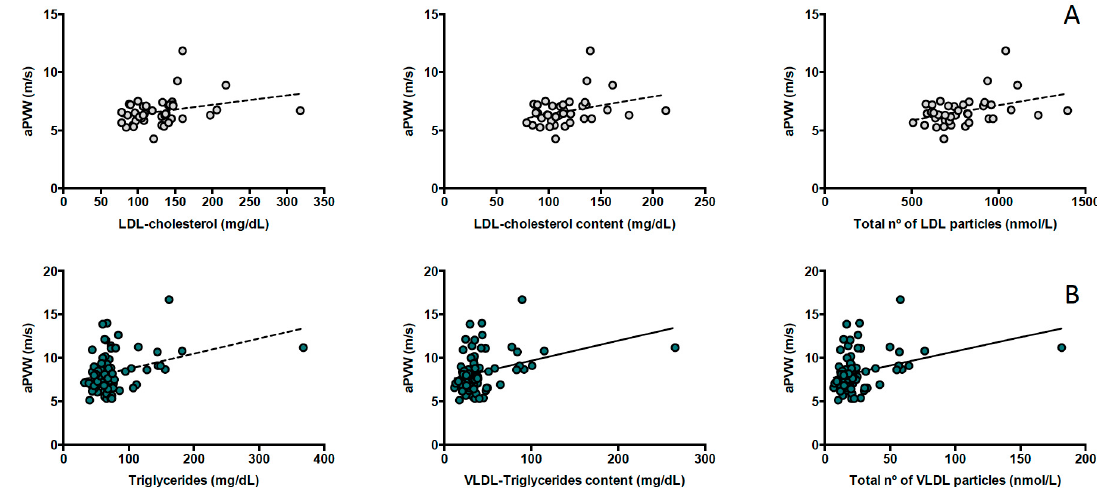
Figure 2. ( A ) Association between aortic pulse wave velocity (aPWV) and NMR-assessed lipoprotein subclass profiles in healthy participants and ( B ) in participants with T1DM. 271 Table 3. Multiple regression analysis for the association between arterial stiffness and NMR-assessed 272 lipoprotein subclass profile. 273